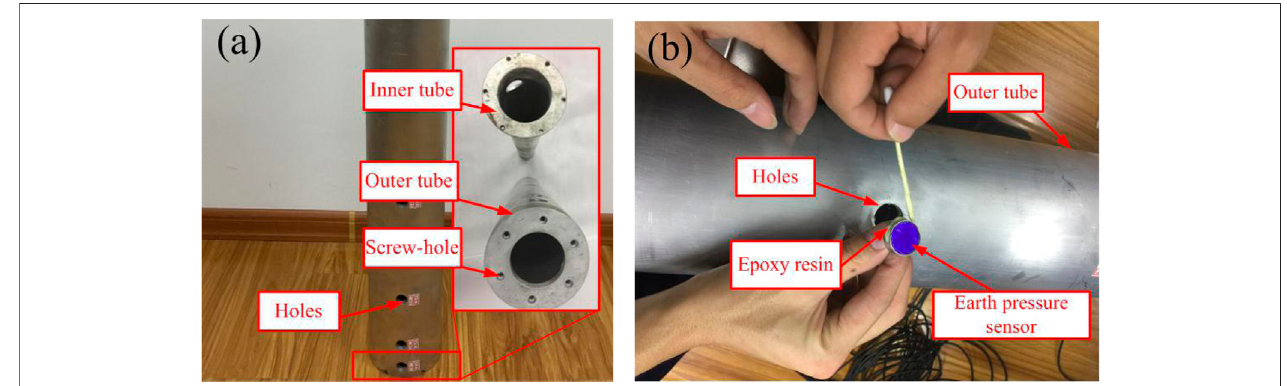
FIGURE 3 | The installation method of transducers: (A) The holes of the pile, (B) Epoxy resin application.